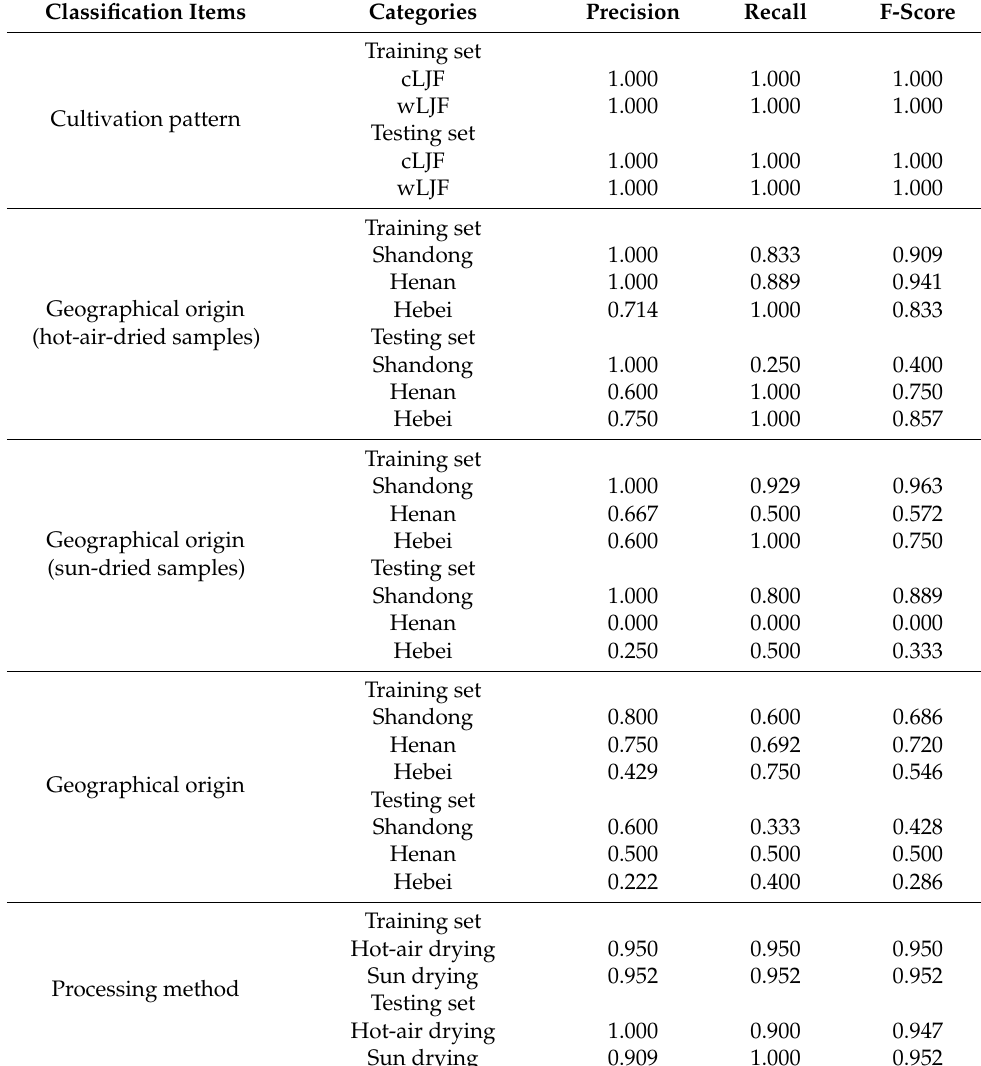
Table 4. LDA model performance for the classifications of 5